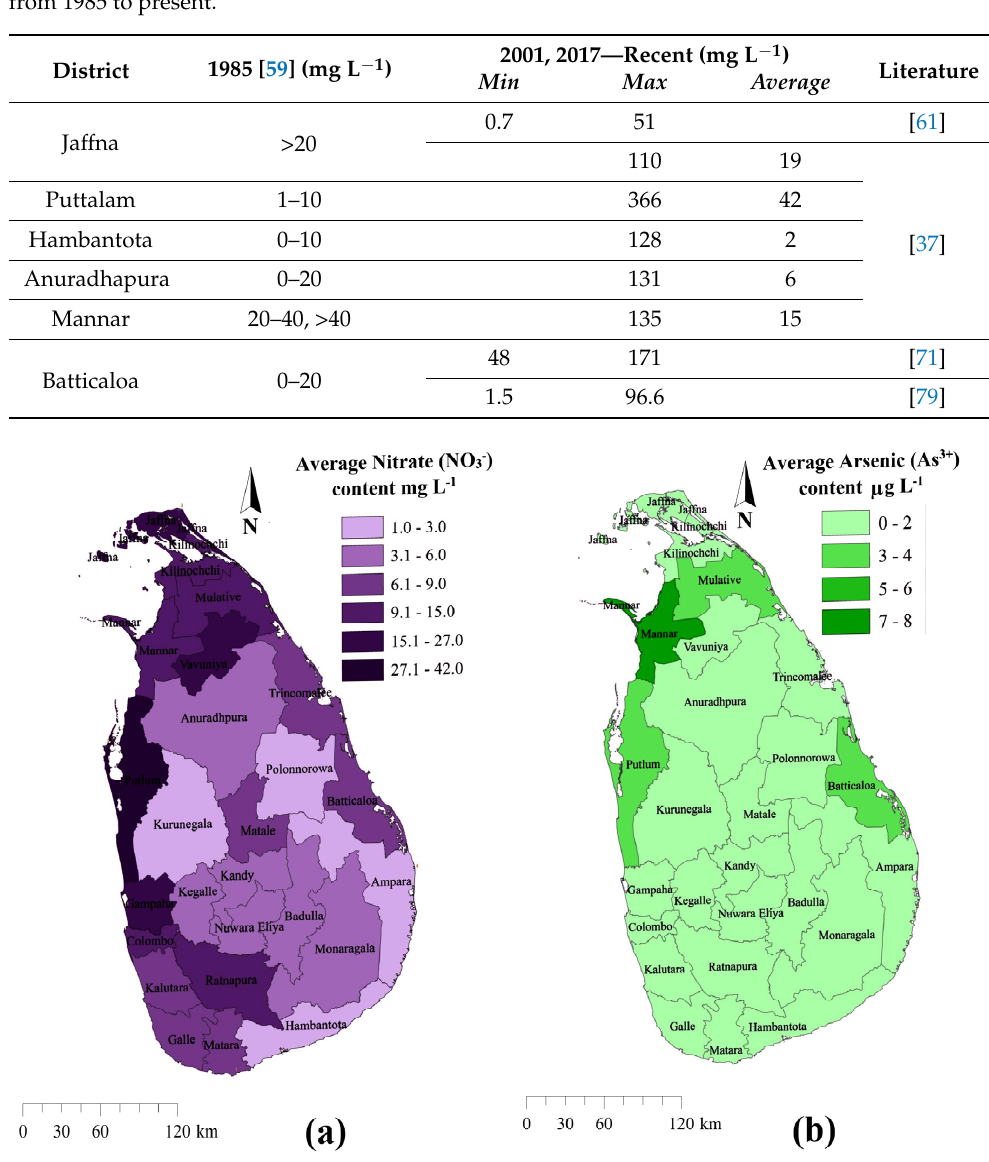
Figure 4. ( a ) Average Nitrate content, and ( b ) Average Arsenic content of the groundwater in each district in Sri Lanka; data extracted from